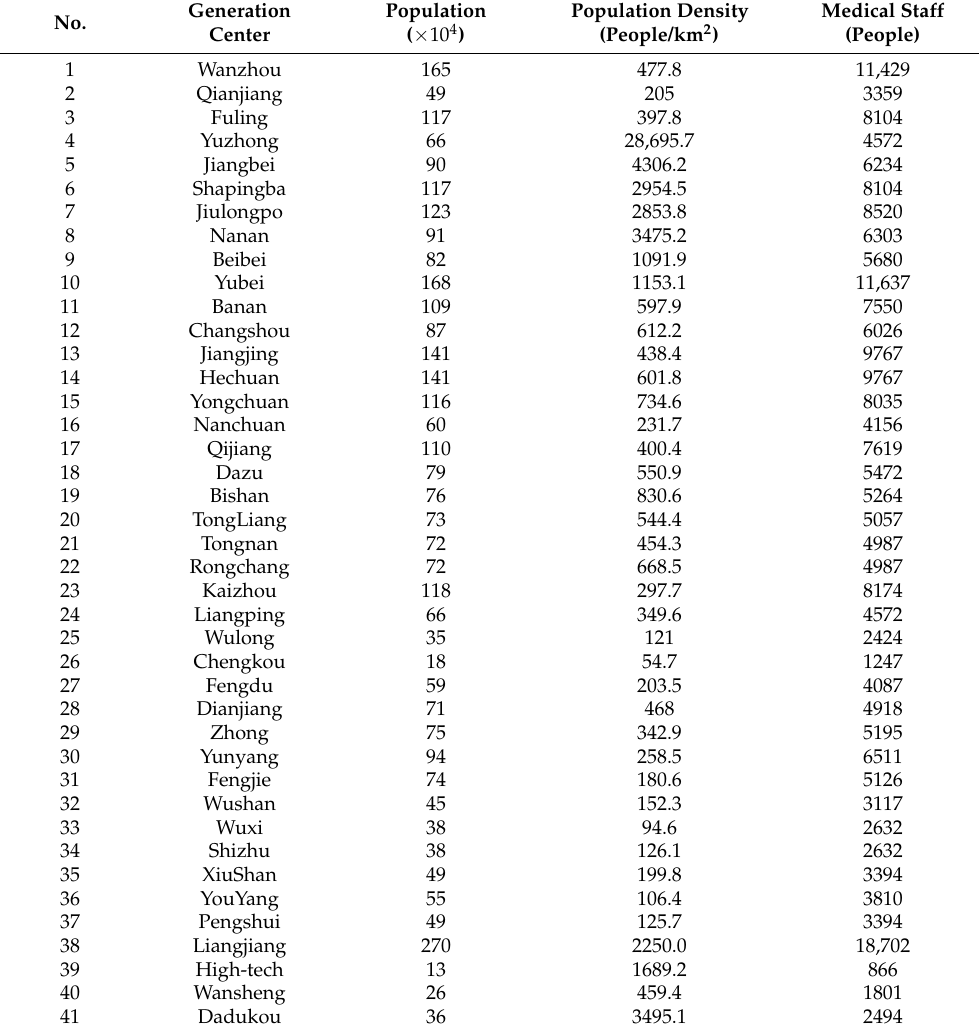
Table 1. Population-related parameters in 41 districts of